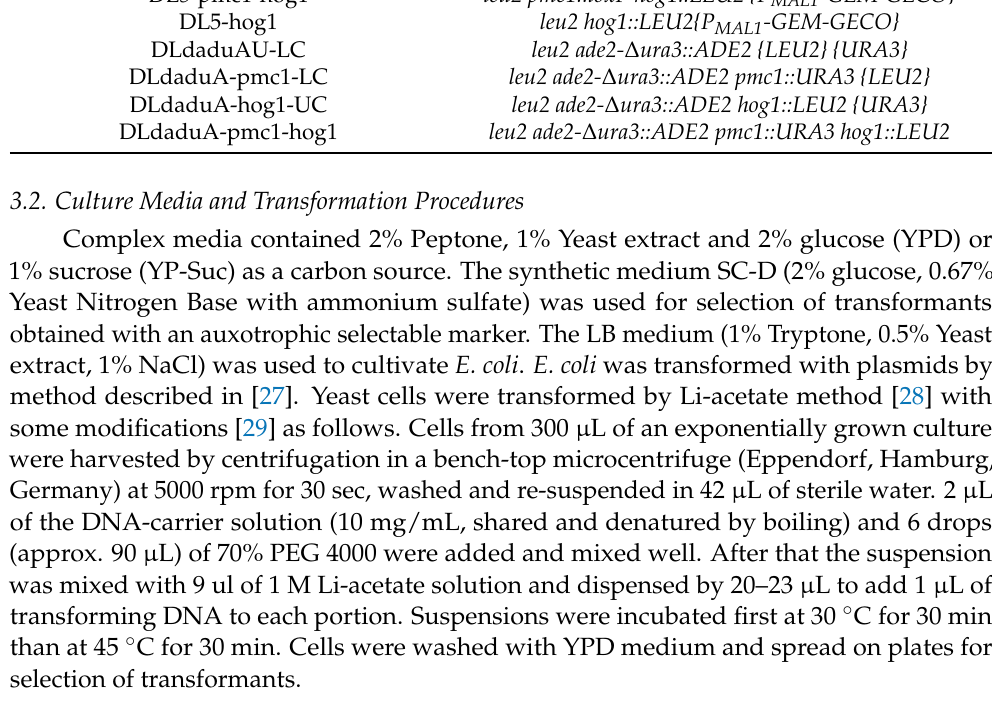
Table 1. O. parapolymorpha strains used in this study. Names of plasmid genes integrated into unidentified genome locus as a part of a plasmid are shown in brackets. Strain Genotype DL1-L leu2 DLdaduA leu2 ade2- ∆ ura3::ADE2 DL1-LC leu2 {LEU2} DL-pmc1-LC leu2 pmc1::loxP {LEU2} DL5 leu2 {P MAL1 -GEM-GECO} DL5-LC leu2 {P MAL1 -GEM-GECO} {LEU2} DL5-pmc1-LC